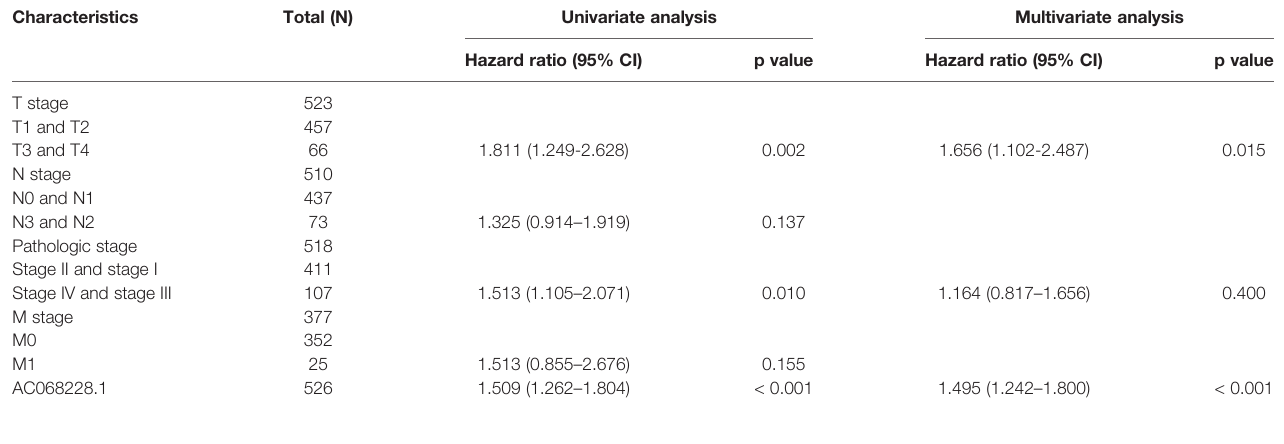
TABLE 3 | Univariate and multivariate Cox regression analyses of different parameters on progression-free survival in lung adenocarcinoma.